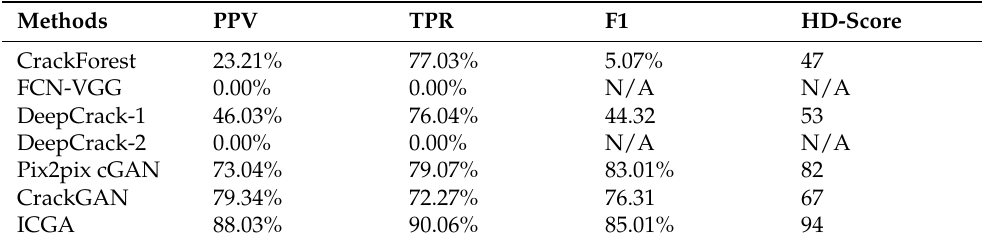
Table 2. Comparison of quantitative evaluations on the Roadway cracks